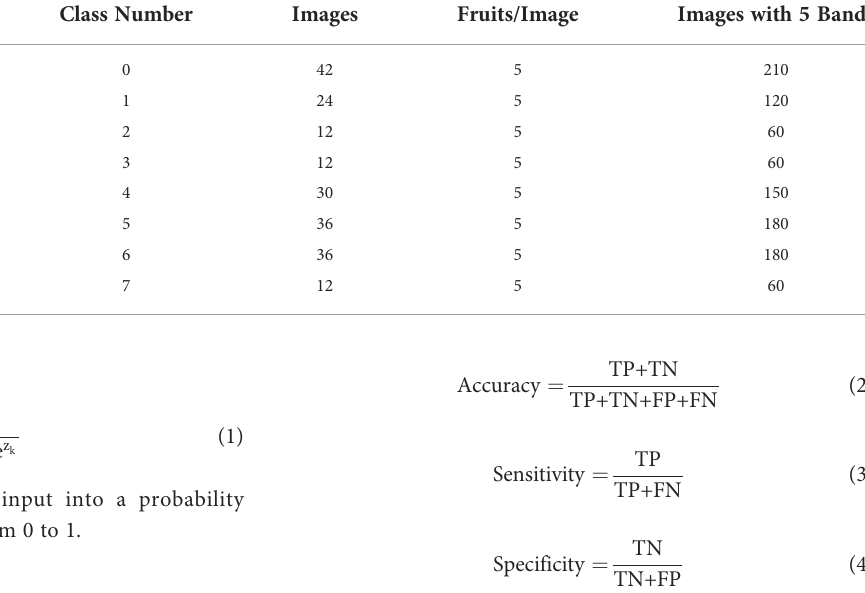
TABLE 1 Number of sampled HSI images with each peel